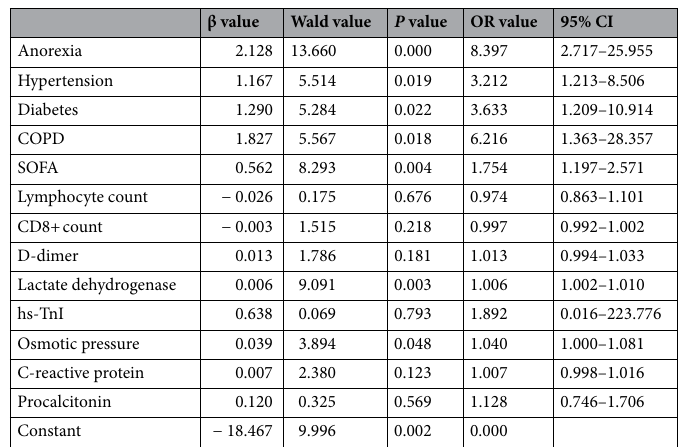
Table 5. Risk factors associated with 28-day mortality in older adult patients with COVID-19. CI, confidence interval; COVID-19, coronavirus disease 2019; hs-TnI, high-sensitivity troponin I; OR, odds ratio; COPD, chronic obstructive pulmonary disease; SOFA, Sequential Organ Failure Assessment.